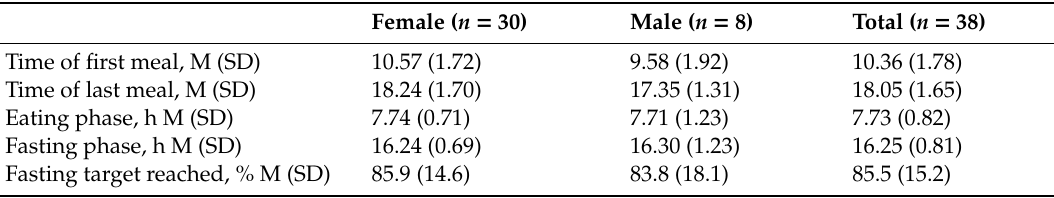
Table 2. Diary of participants in the TRF-GP pilot study 2019.